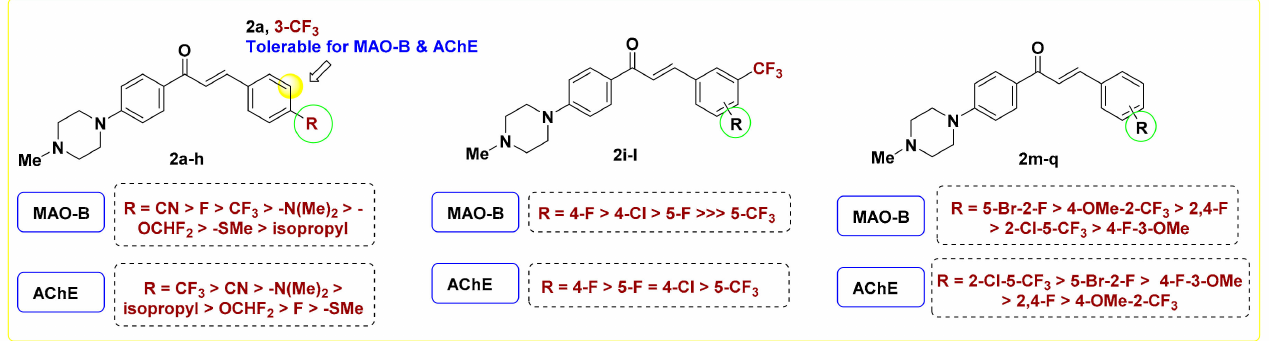
Figure 3. SAR analysis of the target compounds 2a – q for MAO-B/AChE